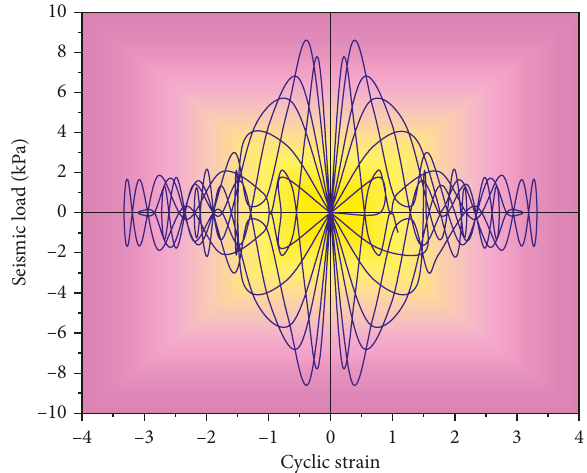
Figure 7: Seismic load (kPa) vs cyclic strain at the base of a concrete footing, configuration-1.